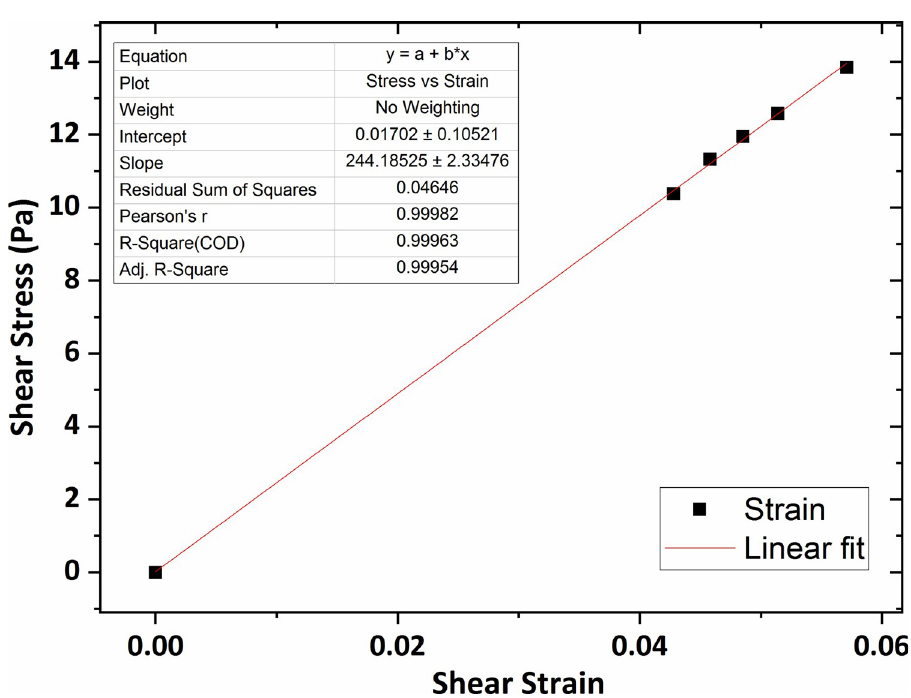
Fig 13. The graph of shear stress versus shear strain for the collagen gel of 0.2 wt % percent concentration.